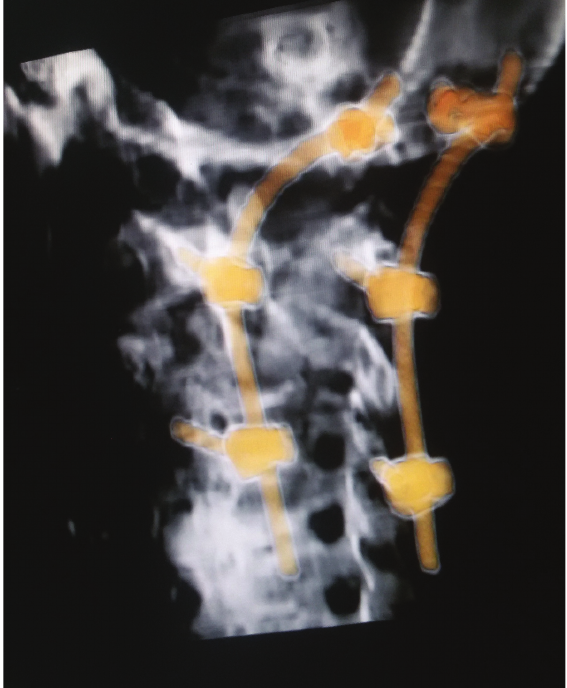
Figure 6. CT spine reconstruction showing projection and final alignment of the construct.